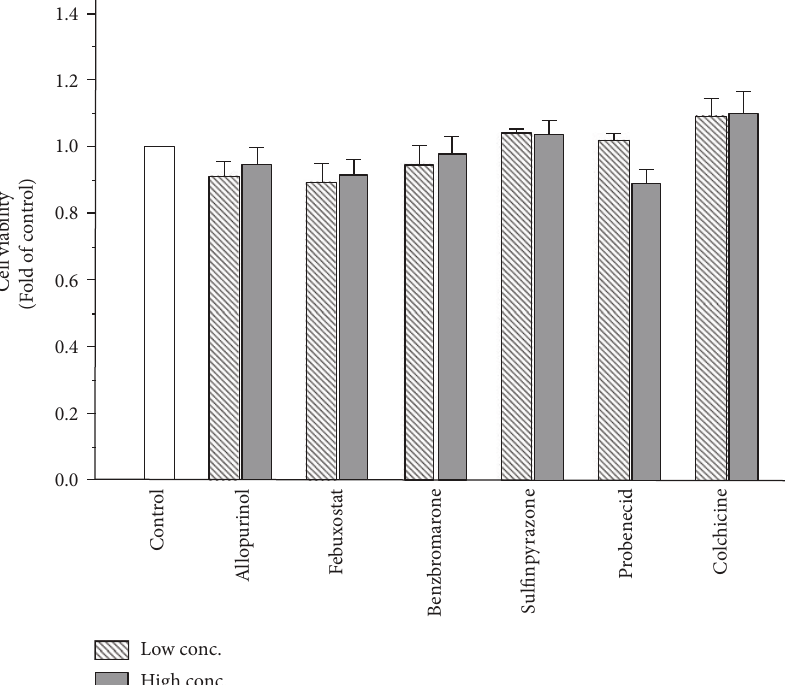
Figure 2: Viability of HepaRG cells following exposure to antigout drugs. HepaRG cells were exposed to allopurinol (14.7 and 22.1 μ M), febuxostat (5.66 and 13.09 μ M), benzbromarone (4.24 and 7.73 μ M), sul fi npyrazone (32.24 and 56.04 μ M), probenecid (243.9 and 520.6 μ M), and colchicine (7.51 × 10 -4 and 0.075 μ M) for 24 h. Cell viability was monitored by measuring cellular acid phosphatase activity using p -nitrophenylphosphate as a substrate. Data shown are the mean ± standard error (SE) ( n = 3